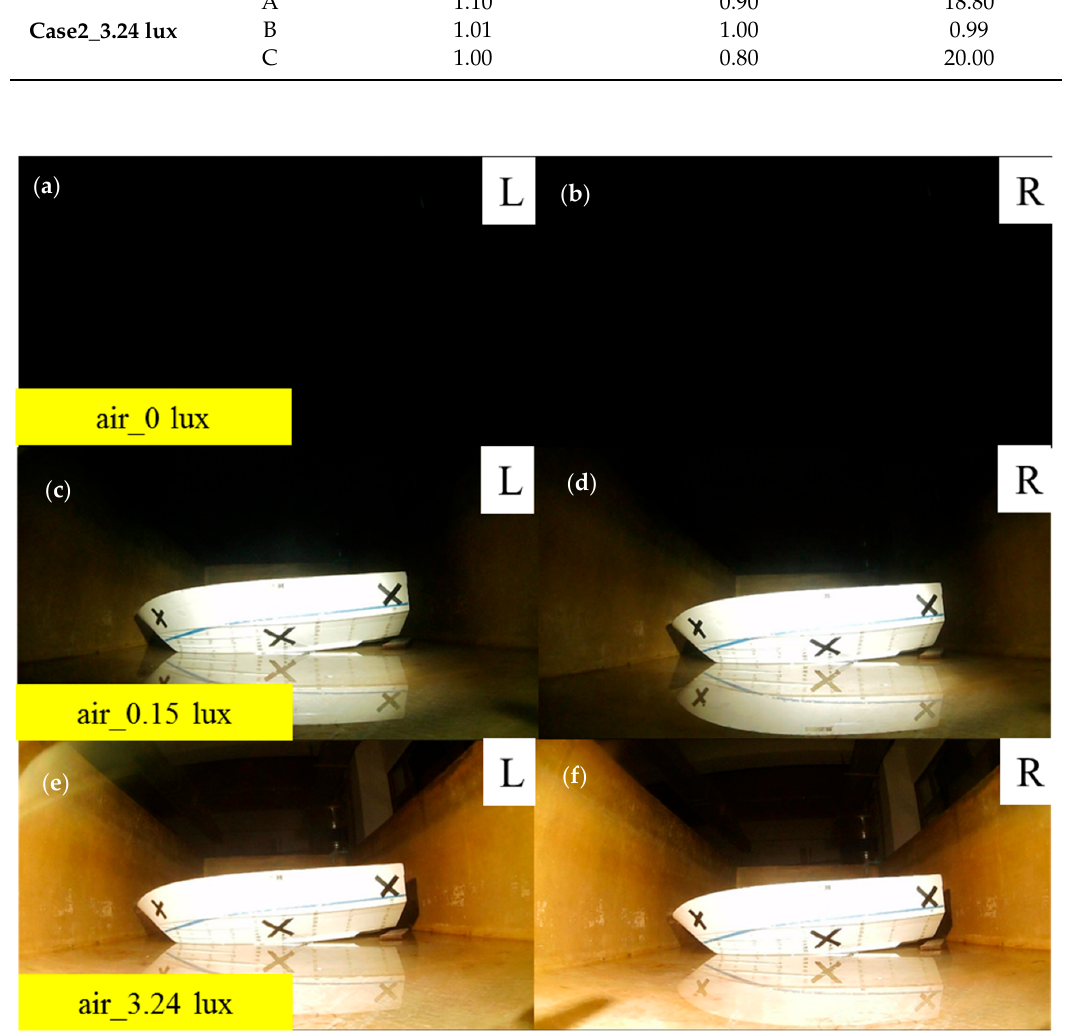
Figure 26. Case 1: Images captured from left and right cameras in the out-of-water environment with an illuminance of 0 lux ( a , b ); 0.15 lux ( c , d ); and 3.24 lux ( e , f ).